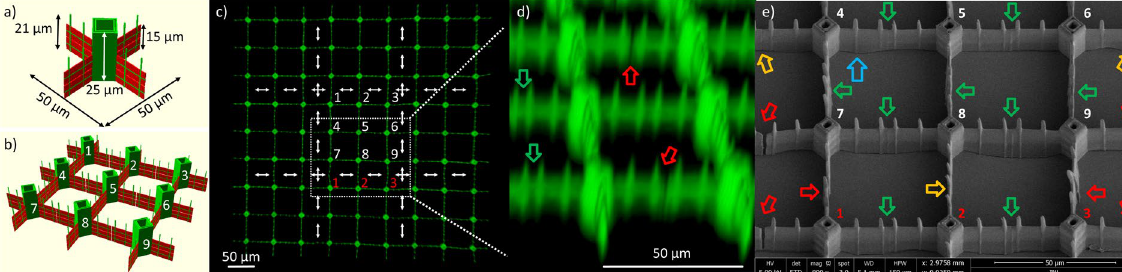
Figure 2. 3D unsupported test structure for multi-beam writing. ( a ) 3D visualization of the unit structure, showing traced lines in green and voxel extension in the Z-direction in red. ( b ) 3D representation of the DOE replication of 9 identical unit structures. ( c ) Confocal fluorescence image of the full structure, where white arrows indicate the stitching between different fabrication replications. A white dotted square indicates the highlighted region in ( e ) where white numbers (1–9) indicates structures from one DOE replication, while red numbers (1–3) are unit structures from another DOE replication. ( d ) Tilted 3D confocal fluorescence image with arrows indicating error -free stitching in green and incomplete stitching in red. ( e ) Tilted-view SEM micrograph of the unsupported stitching. Green arrows indicate complete stitching inside the same DOE replication, while orange and red arrows indicate complete and incomplete stitching between structures from different DOE replications, respectively. One example of the sub-micrometer feature created by the difference between horizontal and vertical lines is indicated by the blue arrow.